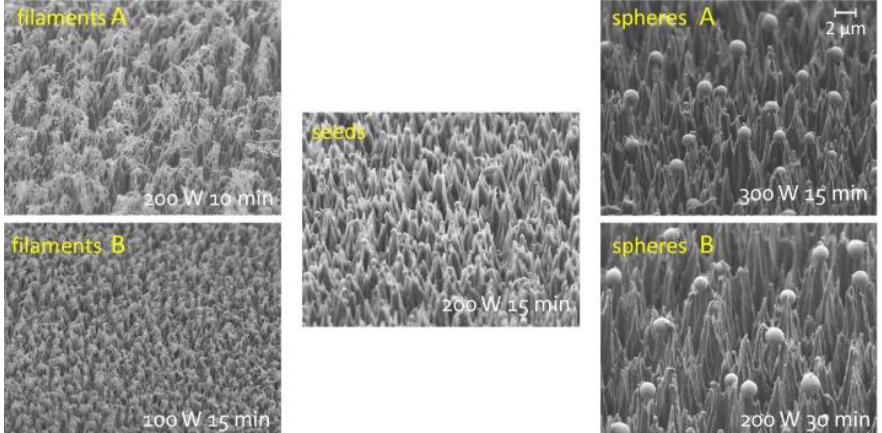
Figure 8. SEM images of Teflon® surfaces treated by a self-masked, oxygen-fed plasma process. The effect of increasing the process time at constant power (200 W) is visible on the diagonal from the upper-left to the lower-right image. The effect of increasing the power at a constant process time (15 min) is shown on the diagonal from the lower-left to the upper-right image. Reproduced with permission from [50]. Copyright 2016 Elsevier.